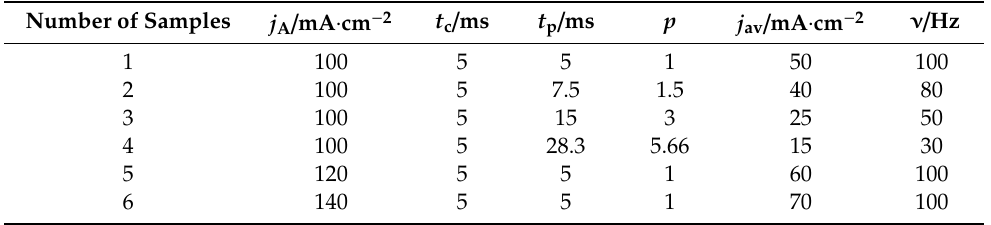
Table 1. The parameters of the pulsating current (PC) regime used in the electrodeposition processes. j A —the current density amplitude, t c —deposition time (on period), t p —pause time (o ff period), p —the pause-to-pulse ratio, j av —the average current density and ν